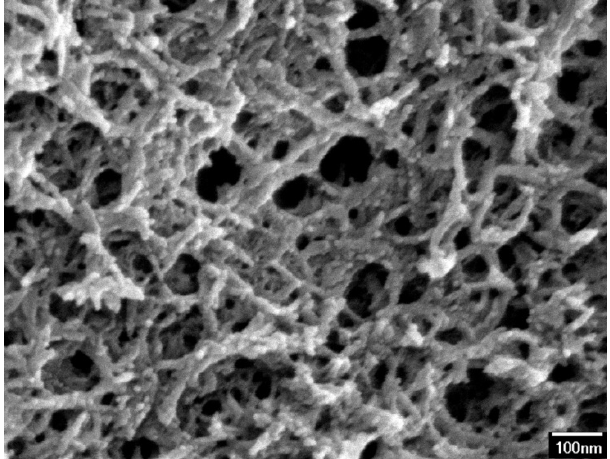
Figure 5. SEM image of the zirconium dioxide